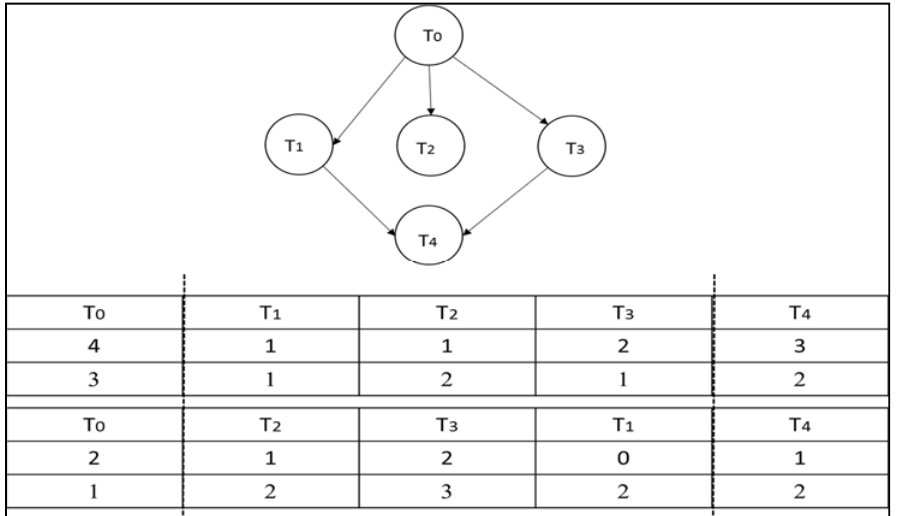
Figure 6. Two chromosomes generated by the initial population generation algorithm.